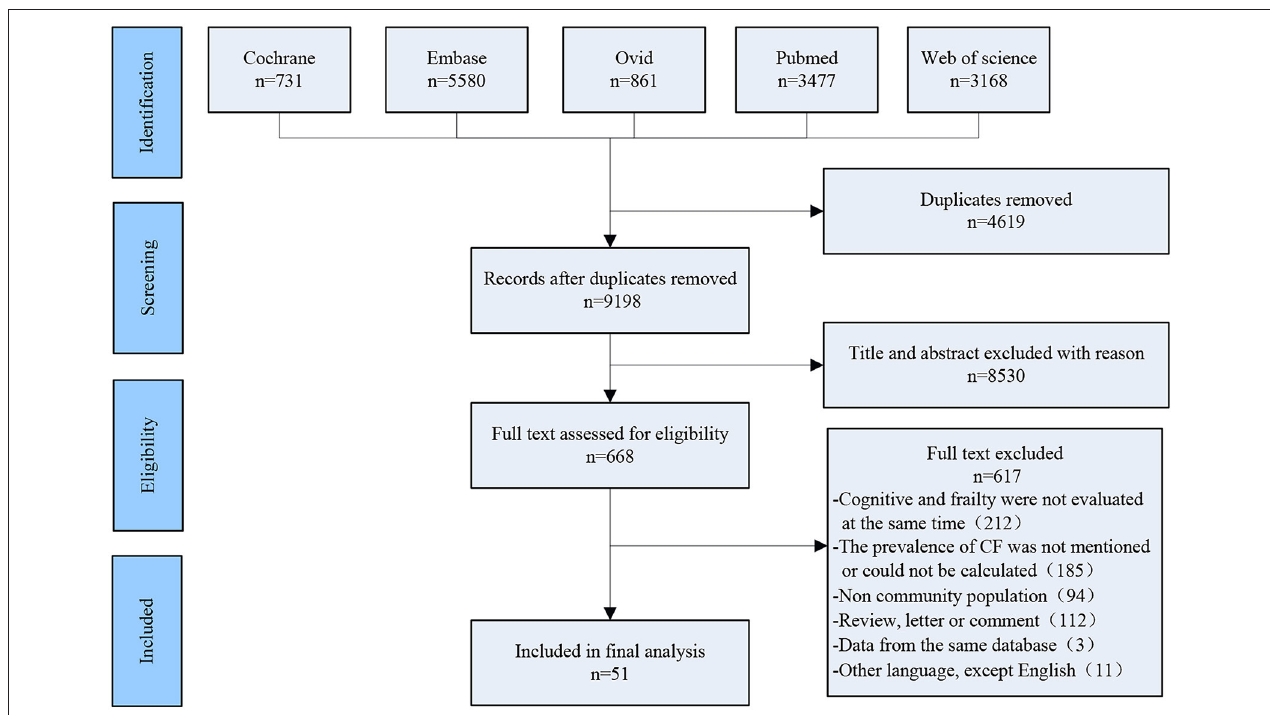
FIGURE 1 | The PRISMA diagram of the study